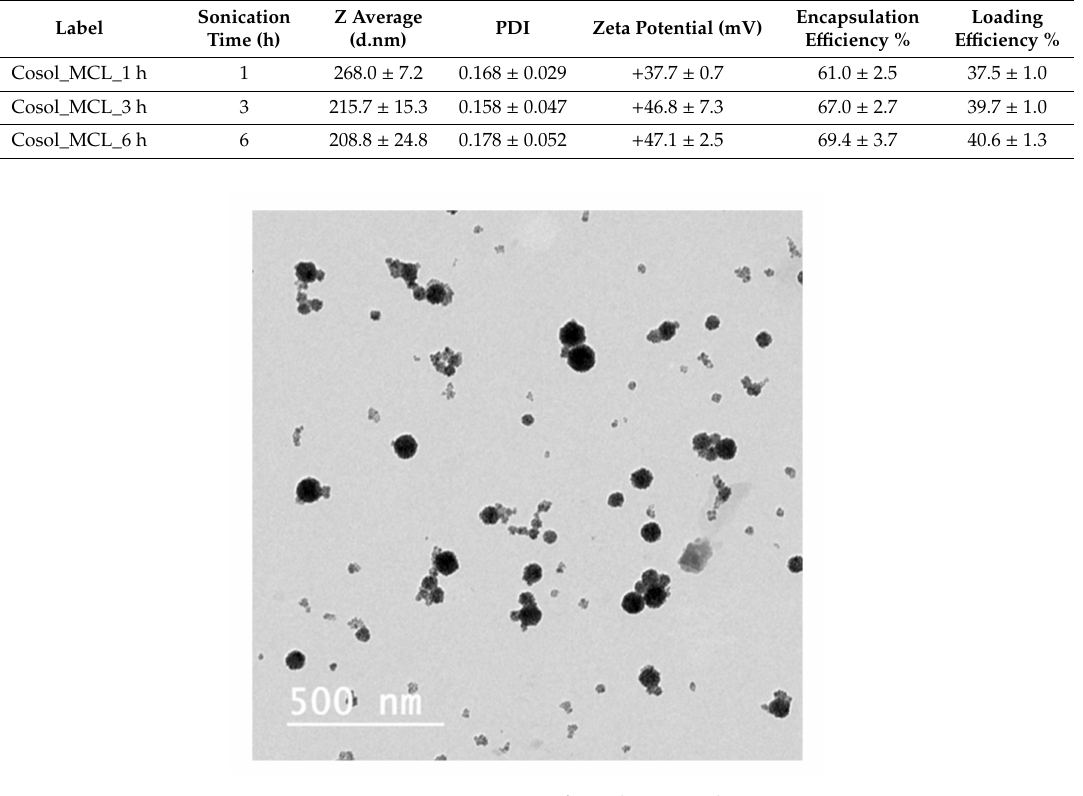
Figure 8. TEM images of cosol_MCL_3